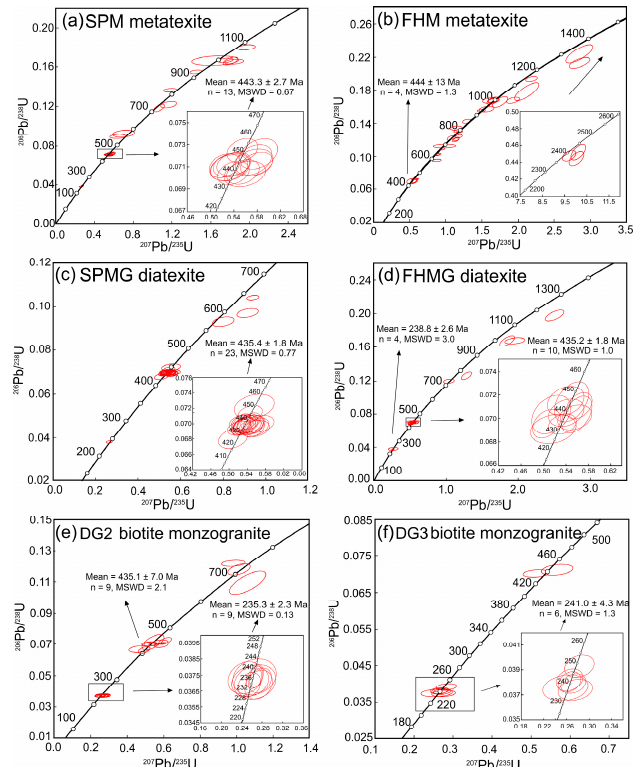
Figure 7. Zircon LA-ICPMS U-Pb concordia diagrams for the samples of Fuhuling with uncertainties on the weighted-mean ages are reported at 2 σ . ( a ) metatexite sample (SPM) and discussed zircon spots. ( b ) metatexite sample (FHM) and discussed zircon rims. ( c ) diatexite sample (SPMG) and discussed zircon spots. ( d ) diatexite sample (FHMG) and discussed zircon spots. ( e ) biotite monzogranite sample (DG2) and discussed zircon spots. ( f ) biotite monzogranite sample (DG2) and discussed zircon spots. See the text for a detailed explanation.